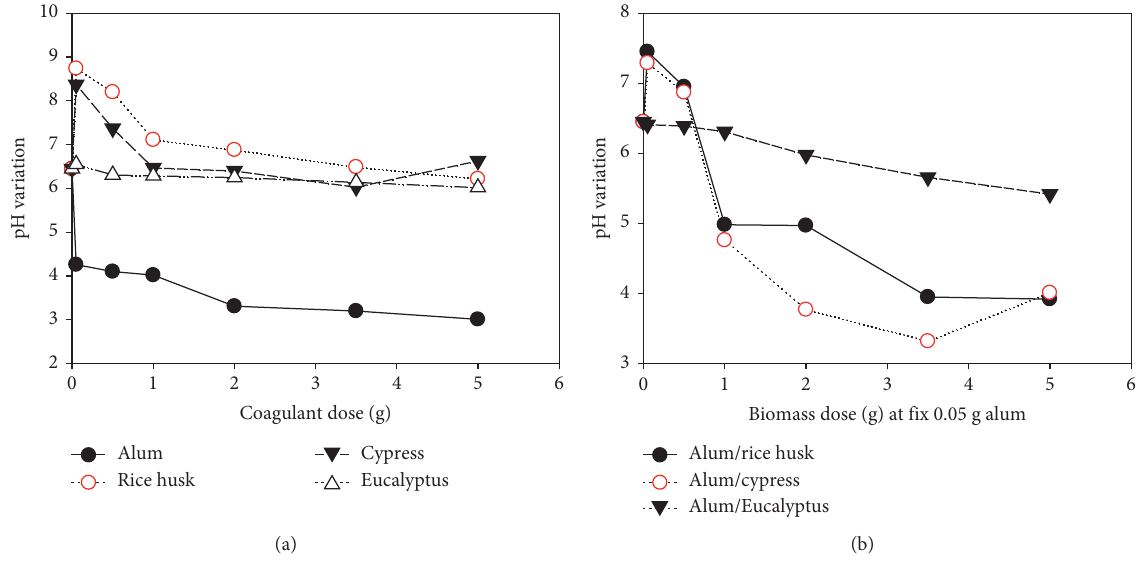
Figure 10: Variation of pH in well water with (a) individual and (b) mixed coagulants.